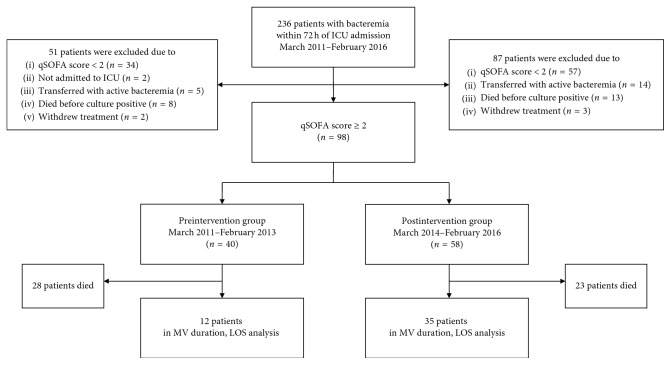
Study flow diagram. ICU: intensive care unit; qSOFA: quick Sequential Organ Failure Assessment; MV: mechanical ventilation; LOS: length of stay.